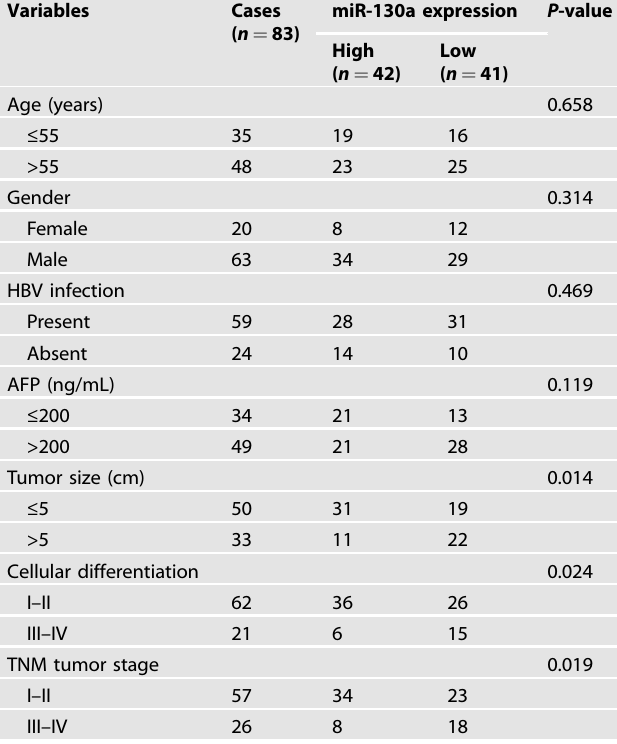
Table 1. The relationship between miR-130a expression and clinicopathological characteristics of patients with